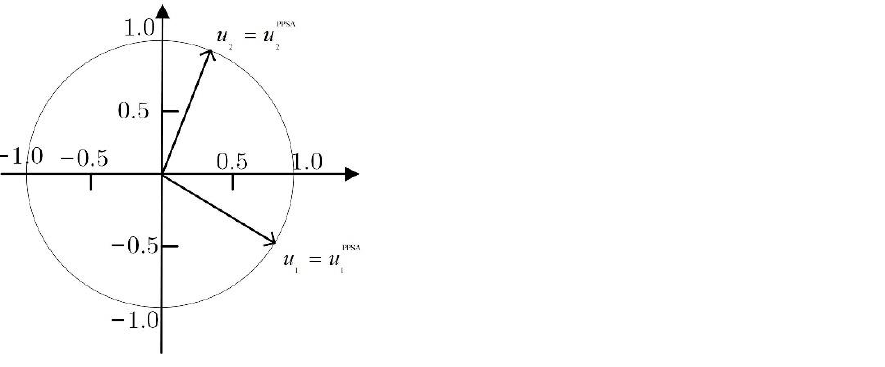
Figure 4. The distribution of two true eigenvectors, and those obtained by PPSA in a unit circle.